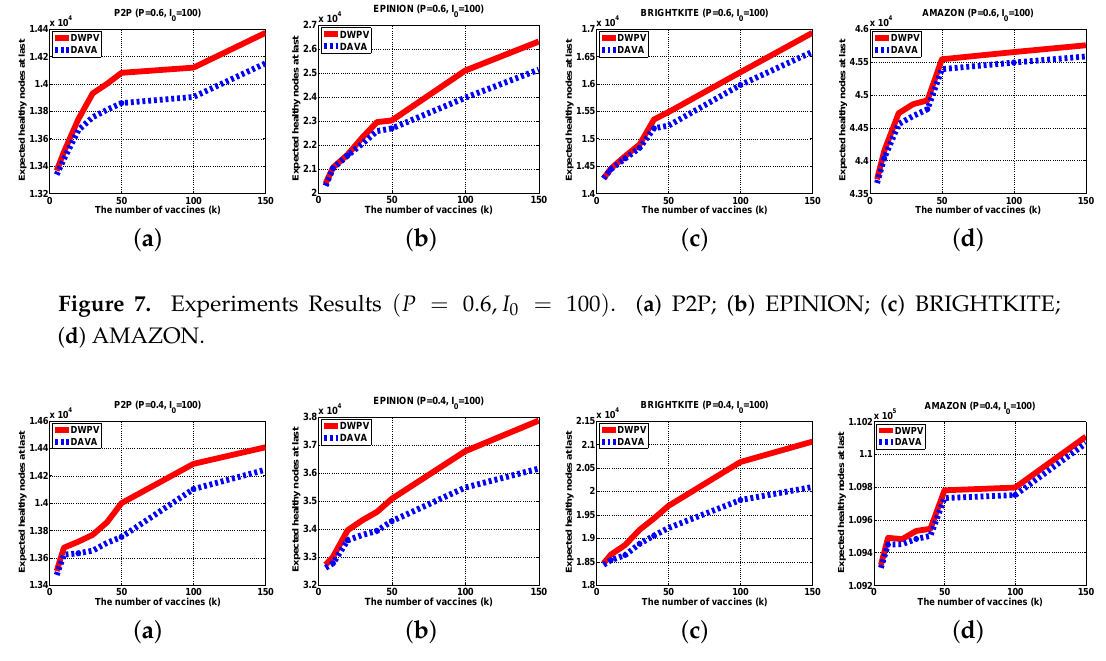
Figure 8. Experiments Results ( P = 0.4, I 0 = 100 ) . ( a ) P2P; ( b ) EPINION; ( c ) BRIGHTKITE; ( d ) AMAZON.